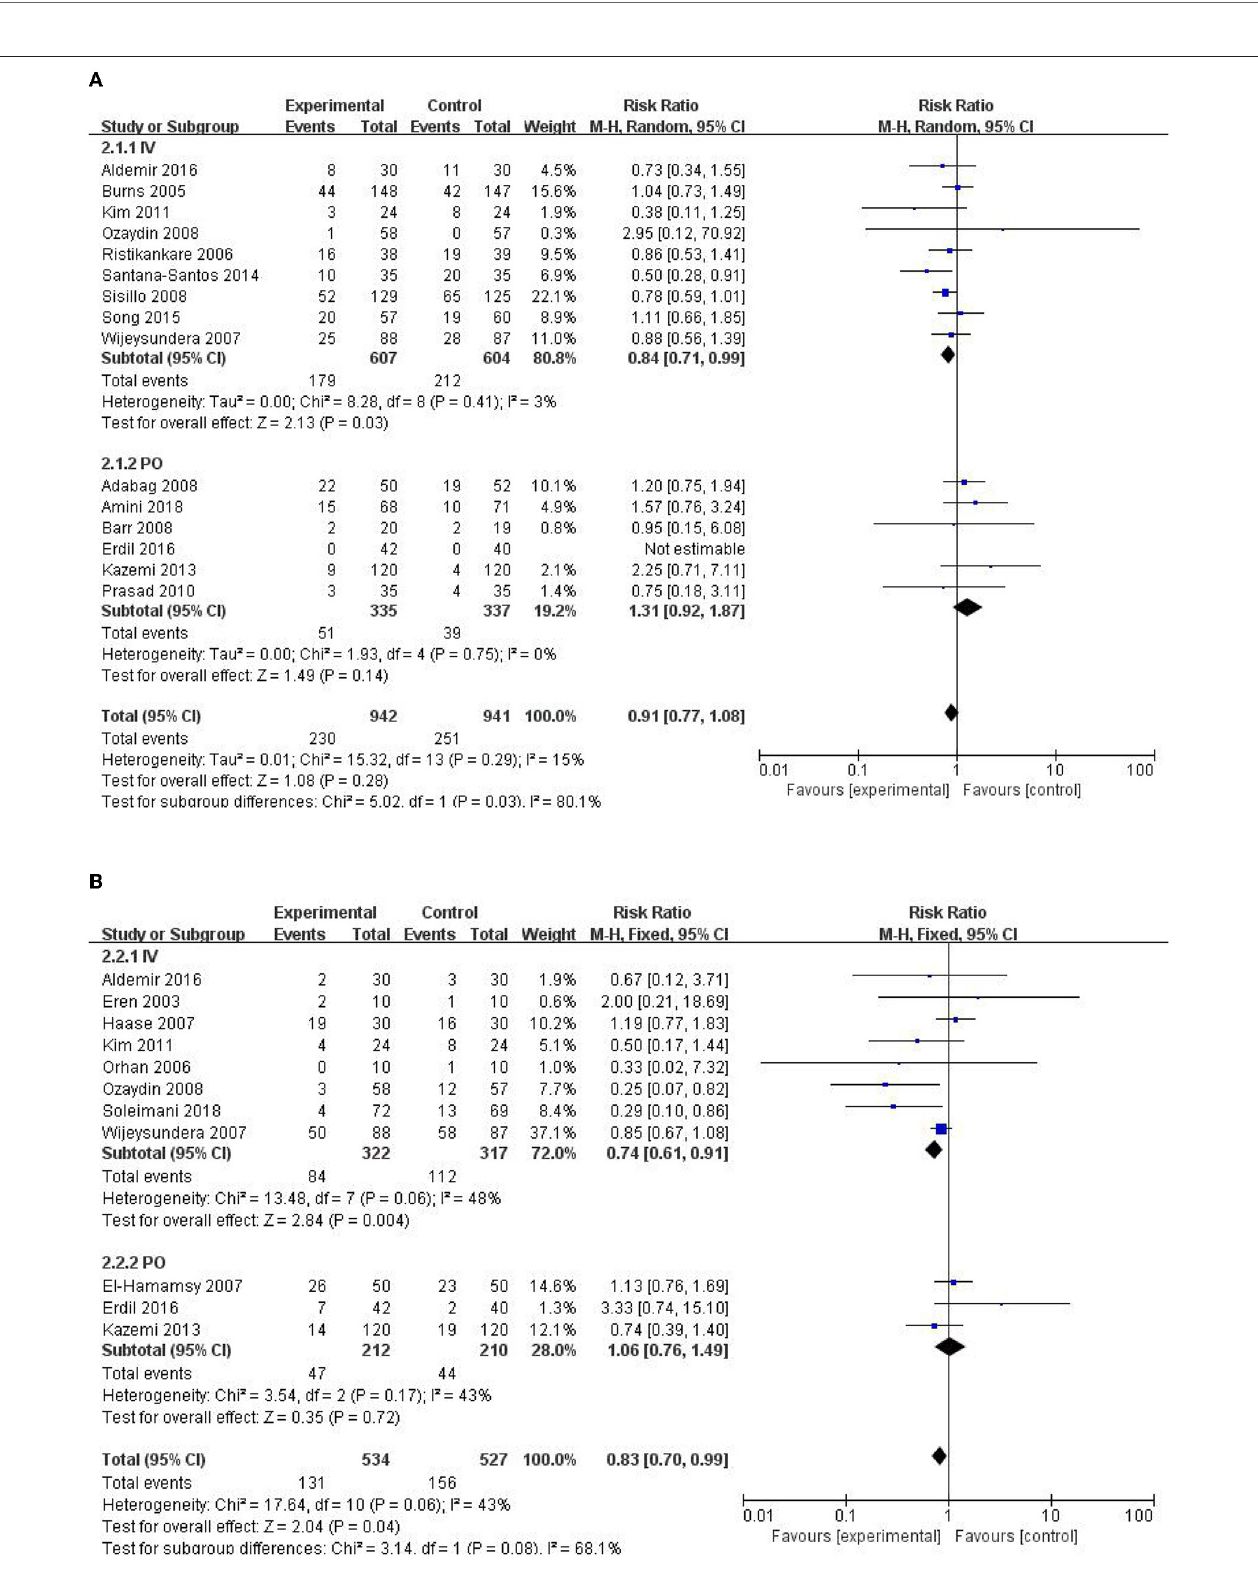
FIGURE 8 | Forest plot of the effects of NAC administration methods on the incidence of AKI and arrhythmia. (A) Forest plot of the incidence of AKI. (B) Forest plot of the incidence of arrhythmia.